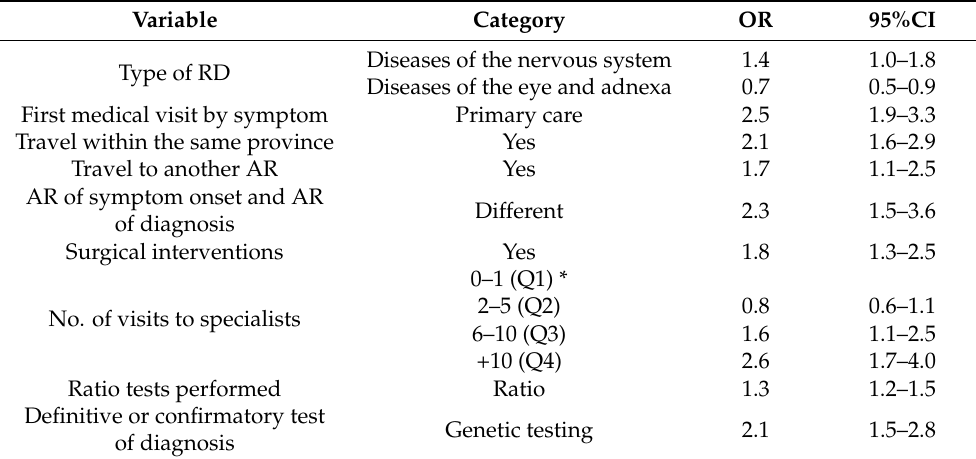
Table 3. Determinants associated with diagnostic delay for RDs in